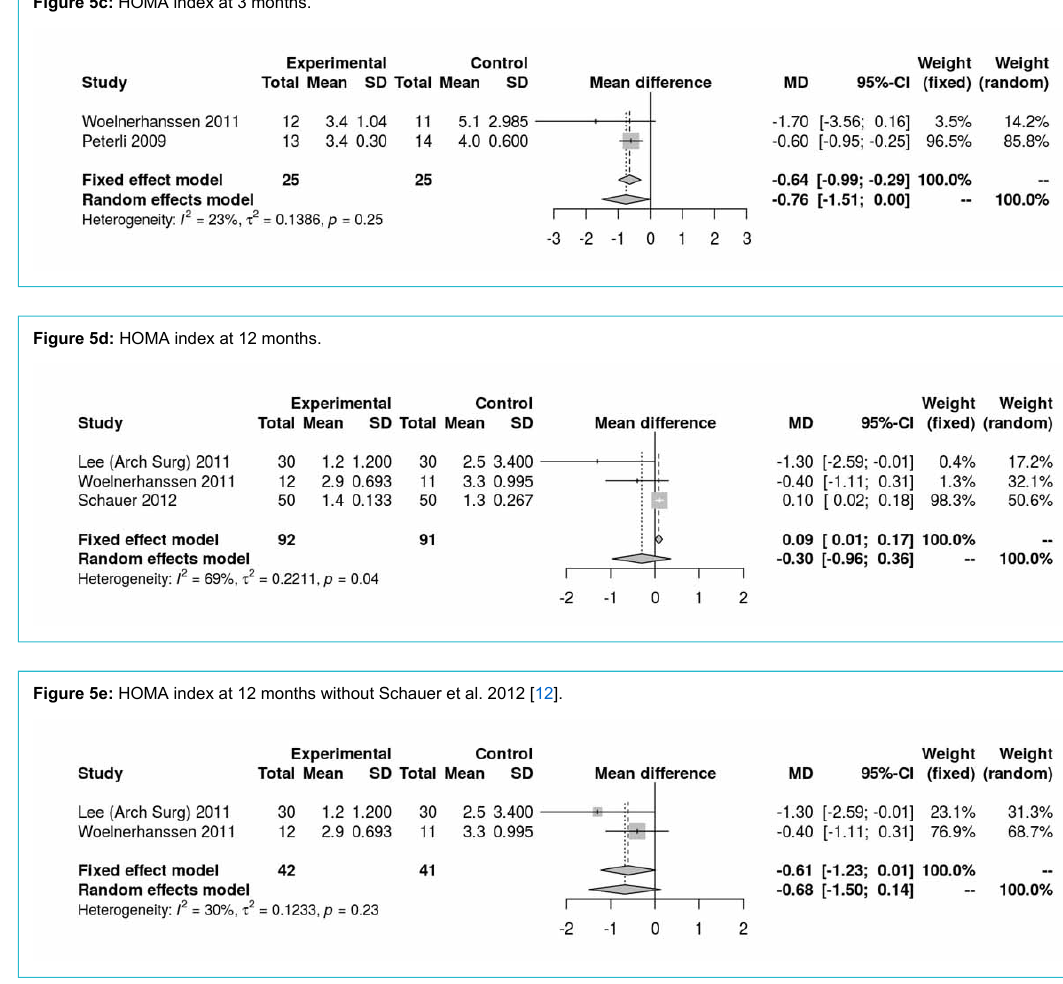
Figure 5c: HOMA index at 3 months.